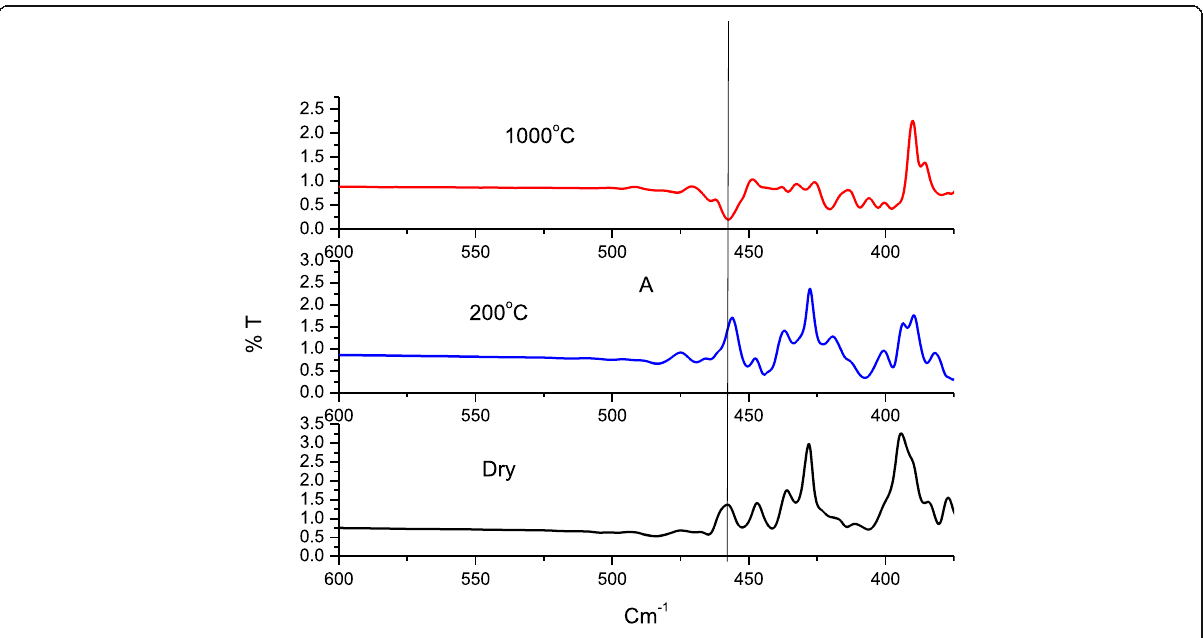
Fig. 3 IR spectra of dried Cu:Fe sample, calcined at 200 °C and at 1000